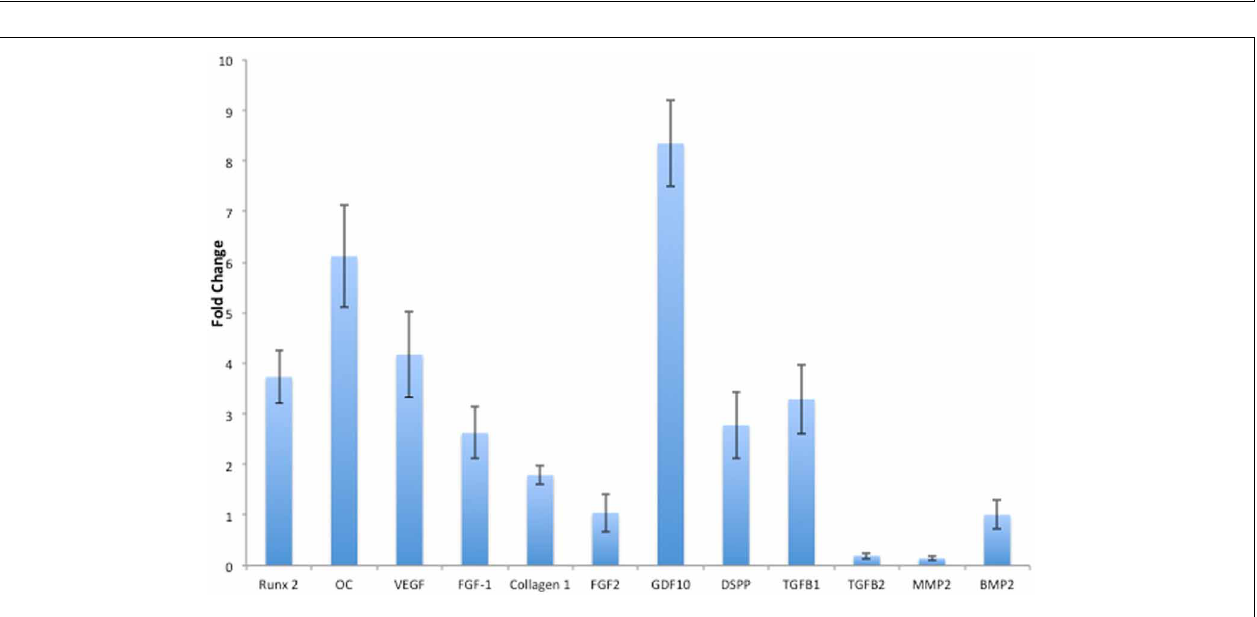
higher magnification in (A1–C1) respectively. The arrows in all the images point to areas where cellular processes branch out to interact with the matrix.